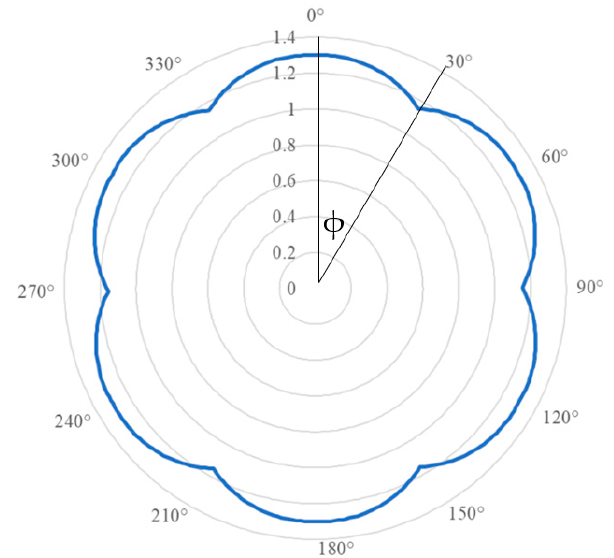
Figure 9. Material Moduli An-isotropic of Hexagonal Close-Packed (HCP) Structures.